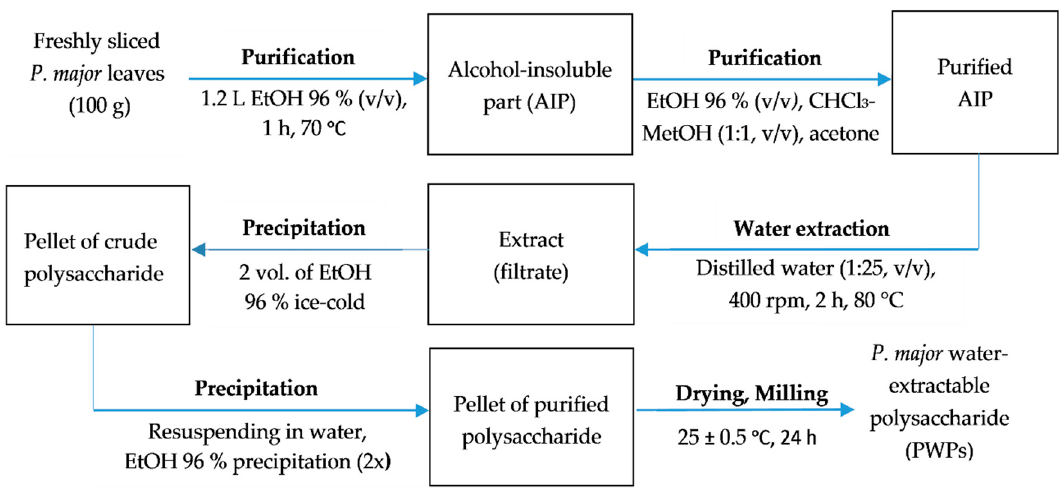
Figure 1. Extraction process of P. major water-extractable polysaccharide (PWPs).